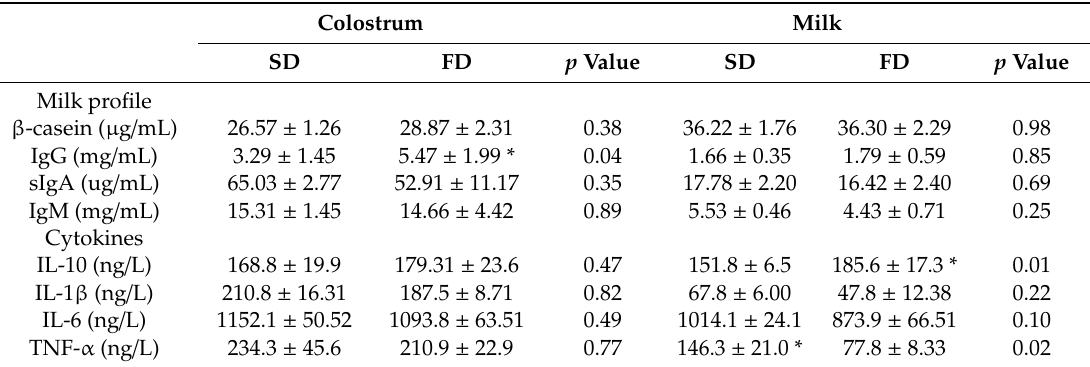
Table 4. E ff ect of the maternal diet with fish oil on the content of the chemical composition, immunoglobulins, and immune cytokines in the colostrum and milk. Colostrum Milk SD FD p Value SD